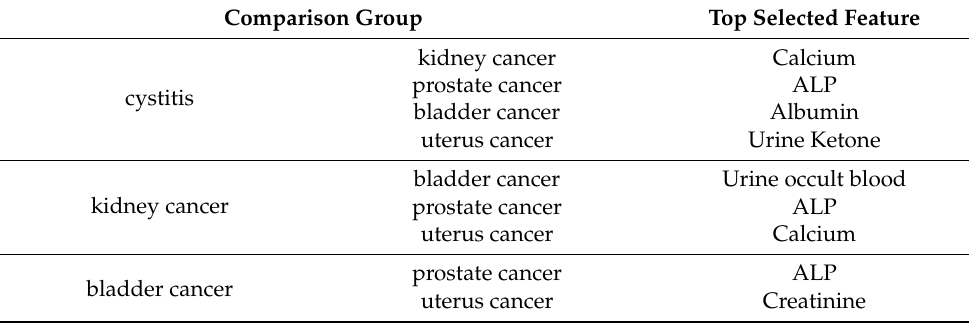
Table 5. The top selected feature from each comparison